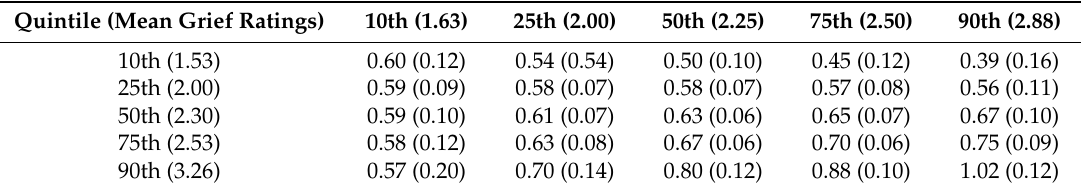
Table 3. Fading Affect Bias Regression Coefficients (SE) across Quintiles (Mean Rating) of Grief and Avoidant Death Attitudes Ratings (large positive coefficients represent large